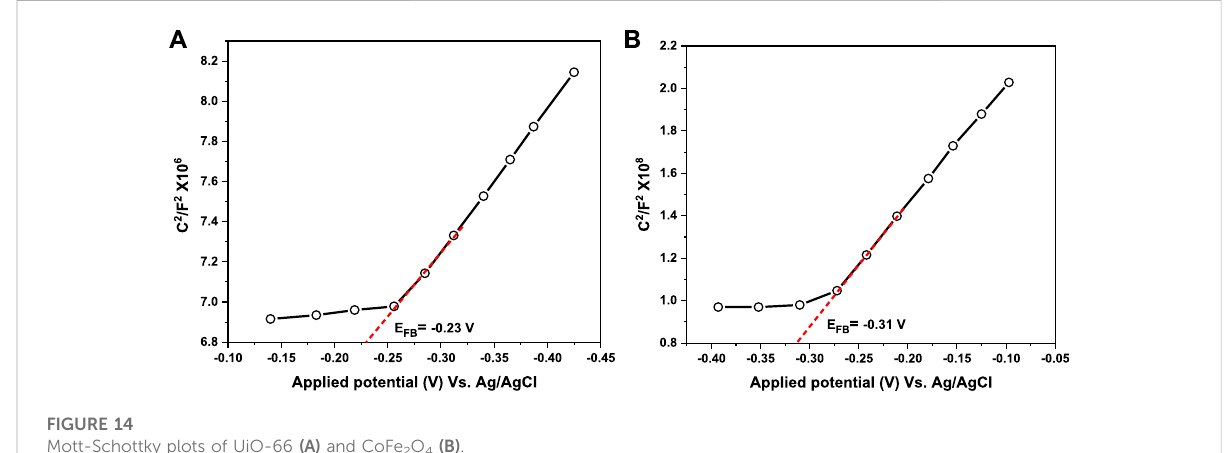
FIGURE 14 Mott-Schottky plots of UiO-66 (A) and CoFe 2 O 4 (B) .